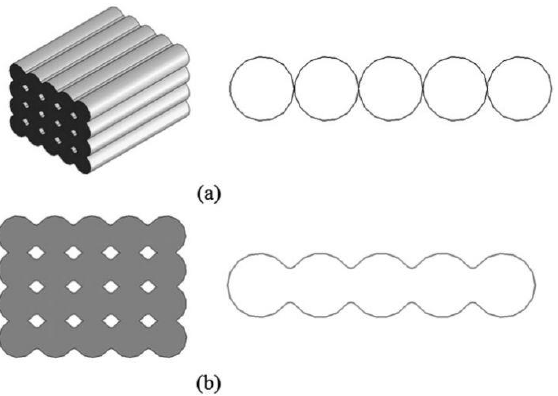
Figure 3. Schematic of: ( a ) assumed position of filaments before any bond form and, ( b ) actual position of filaments after intra-layer and inter-layer bonding is formed. Reprinted with permission from [23], 2014, Taylor and Francis, Abingdon, UK.